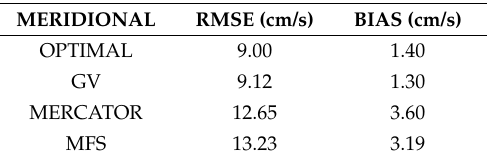
Table 2. BIAS and Root Mean Square Error (RMSE) between the Optimal-GV-MERCATOR-MFS and the HFRsurface currents in the Malta-Sicily Channel. Meridional